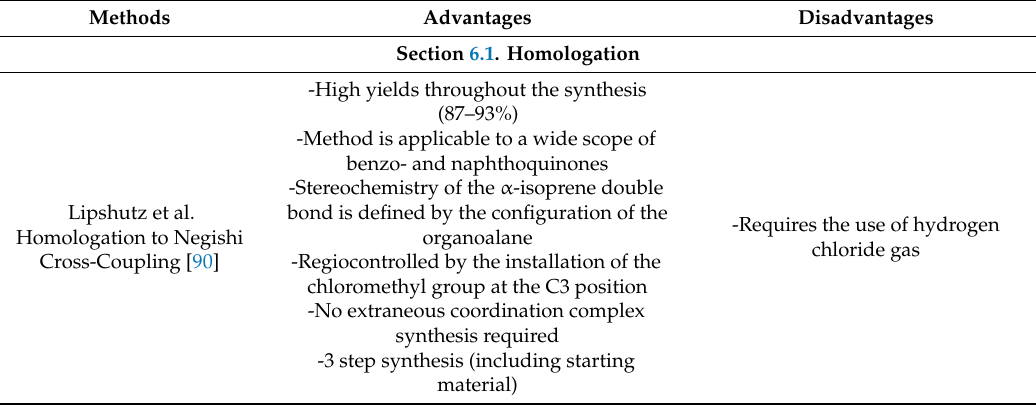
Table 9. Summary of homologation and side chain extension